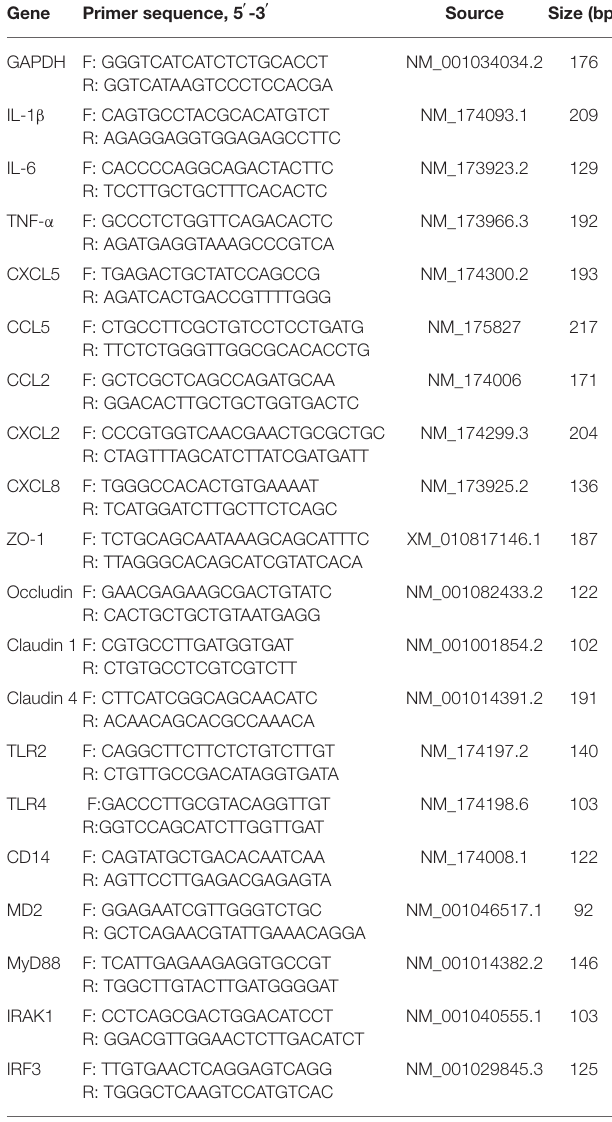
TABLE 1 | Primers for real-time quantitative